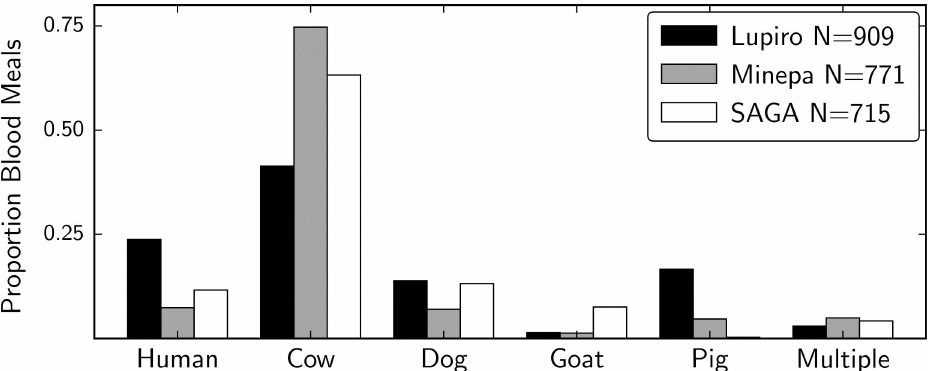
Fig 1. Relative hostchoicebetweenvillages. This figuredescribesthe resultsof bloodmeal analysisof An . arabiensis collectedfrom:Lupiro, Minepa,and Sagamaganga (SAGA). We detectedmultiplehosts in < 5% of individuals. Different combinations of mixed host bloodmealswere pooledand shown as “Multiple”. A few chicken bloodmeals were also detectedat each